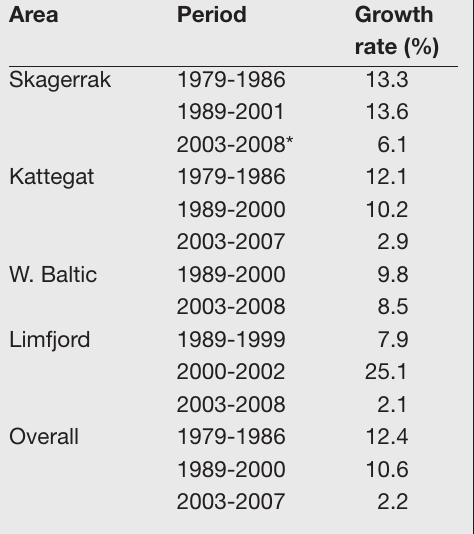
Table 2. Estimated annual growth rates in the 4 subpopulations based on the expo- nential growth model for periods corre- sponding to before, between, and after the two PDV epidemics. Note that some data in this table differs from Teilmann et al 2010 because of differences in data treat-